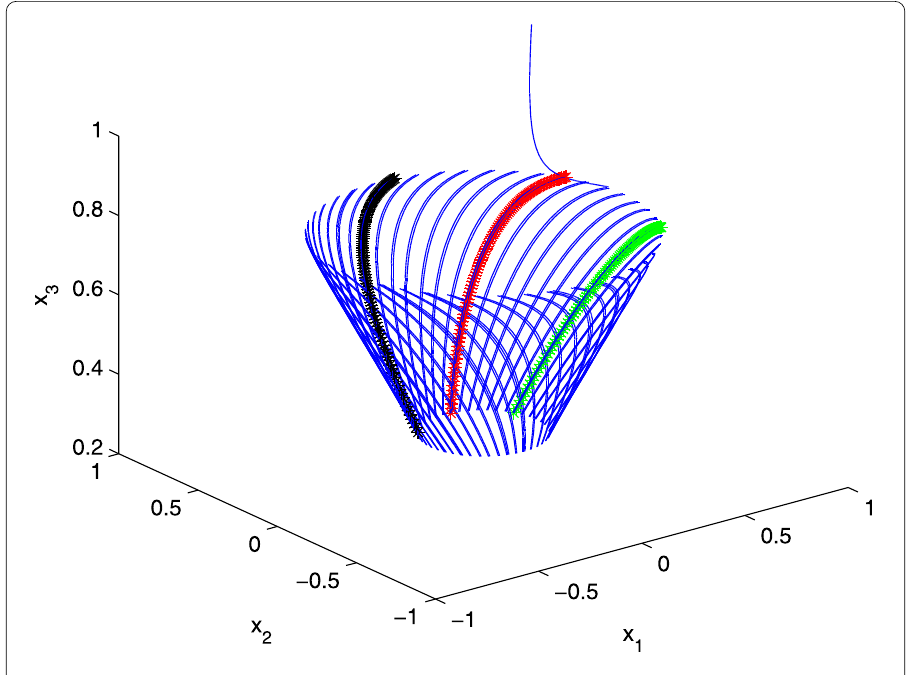
Figure 2 The ( Q , T )-affine-periodic solution of system (27). The black line is the trajectory of x ( t ) for t ∈ (0,1], the red line corresponds to the trajectory of Qx ( t ) for t ∈ (0,1], and the green line corresponds to the trajectory of Q 2 x ( t ) for t ∈ (0,1]. It is easy to see that x ( t ) is a quasi-periodic solution of system